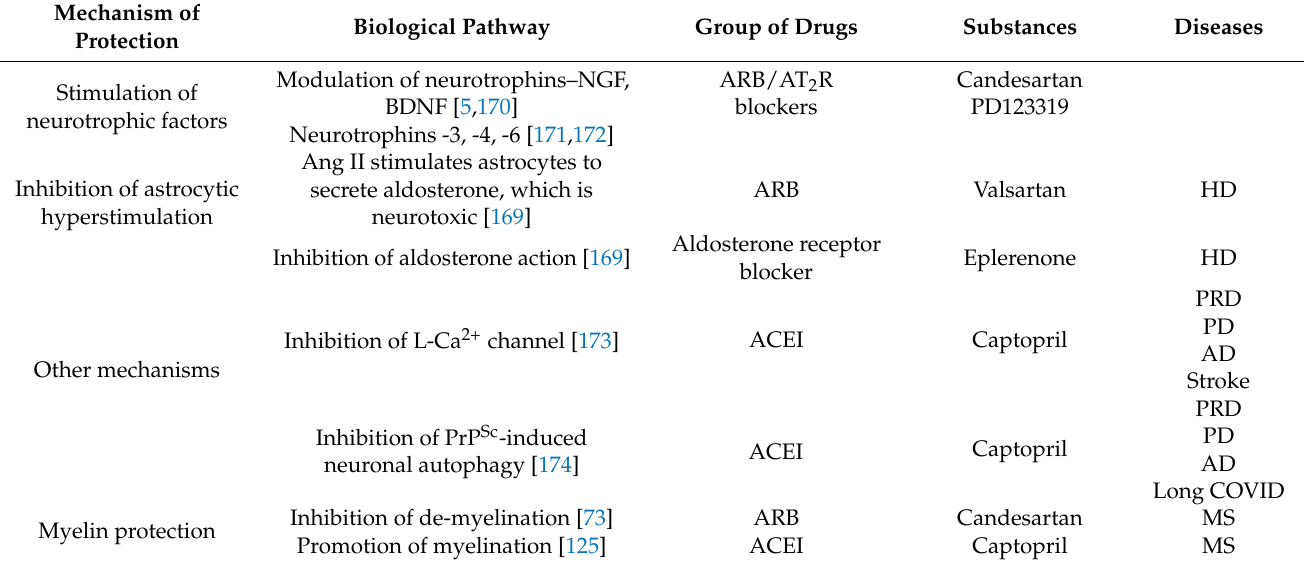
Table 6. Protective mechanisms of RAS pharmacological modulators via stimulation of neurotrophic factors, inhibition of astrocytic stimulation, or other